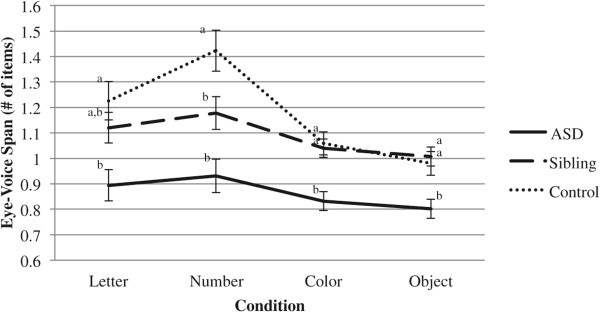
Line graph of condition by group interaction for eye-voice span (EVS). Groups with different subscripts differ at p < .05.